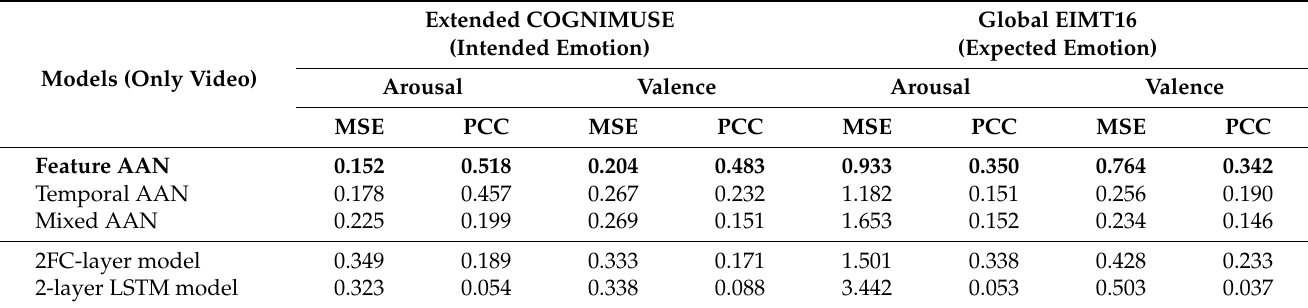
Table 1. The performance of the proposed models using only visual features.